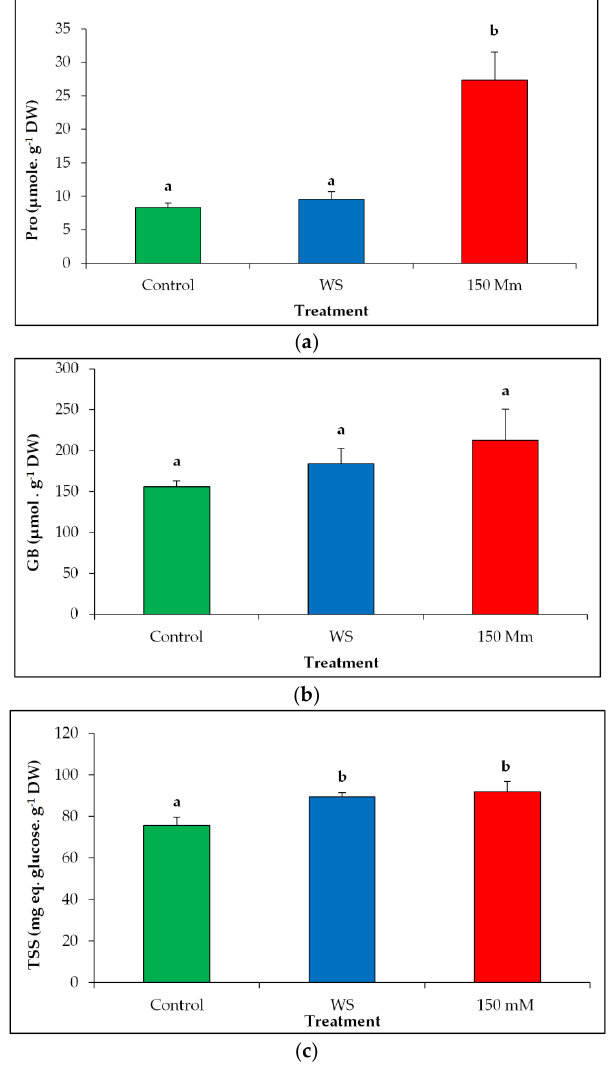
Figure 6. Needle contents of ( a ) proline (Pro); ( b ) glycine betaine (GB); and ( c ) total soluble sugars (TSS), in Larix decidua seedlings after days of water and salt treatments. Values shown are means ± SE ( n = 7). Different letters above the bars indicate significant differences between treatments, according to Tukey’s test ( α =